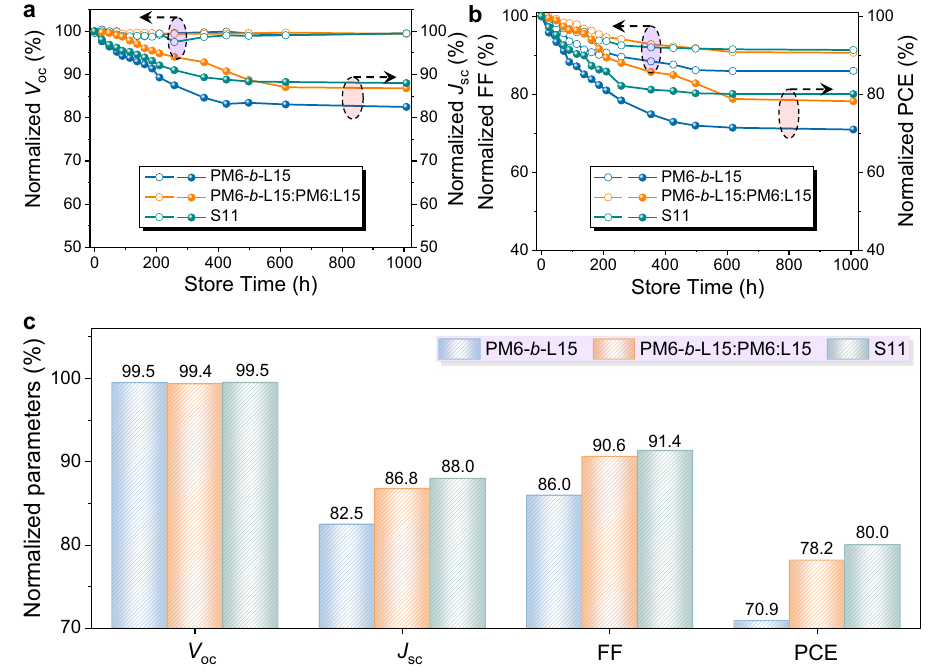
Fig.7|TheComparisonofthermalstability. Evolutionof a V oc , J sc ,and b FF,PCE c retainedphotovoltaicparametersoftheoptimizedsinglecomponentsystemPM6- b - L15-, the ternary system PM6- b -L15:PM6:L15- and the multi-component system S11-based OSCs under 85°C heated